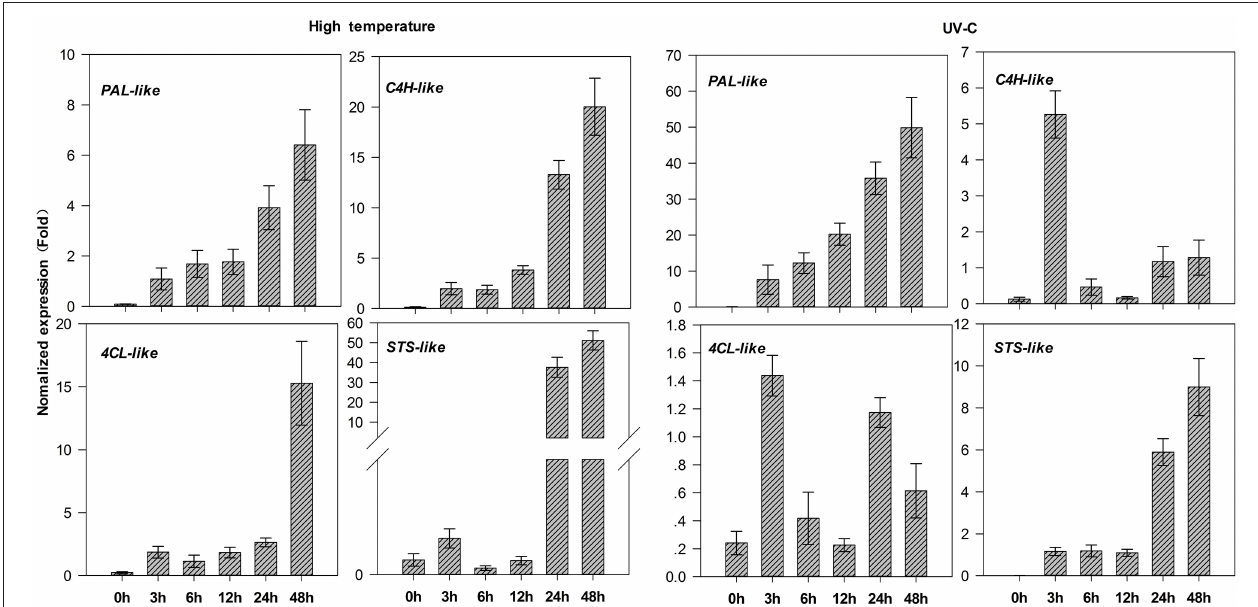
FIGURE 7 | Expression patterns of candidate genes involved in stilbenoid biosynthesis in leaves of Gnetum parvifolium seedlings under stresses. Young seedlings were treated with high temperature (40 ◦ C)/UV-C, respectively, for 0, 3, 6, 12, 24, and 48h. Vertical bars represent the mean ± SD of four separate experiments. PAL-like : comp81110_c0; C4H-like : comp90938_c0; 4CL-like : comp94230_c0; STS-like : comp550004_c0.